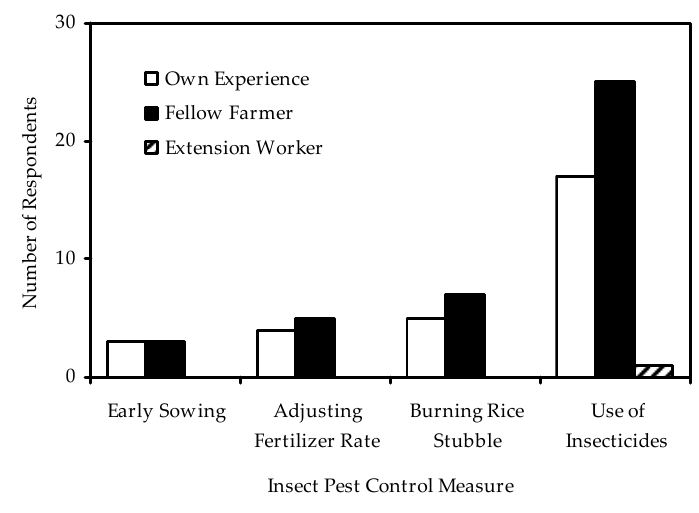
Figure 6. Farmers source of information for rice insect pest management.